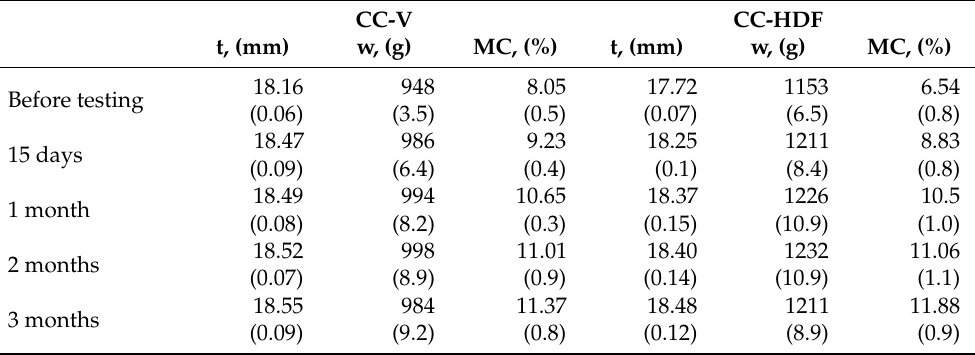
Table 5. Variation of the blockboards’ physical parameters during their exposure in the climatic chamber (average values recorded for each month).